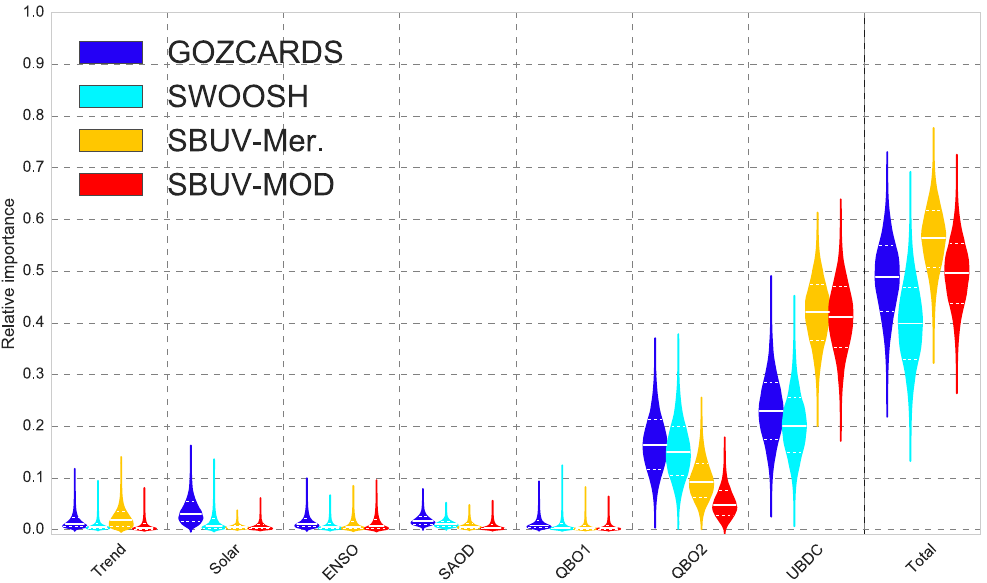
Figure 12. Similar in format and method to Fig. 11a, the relative importance of each regressor using the coefficient of determination ( R 2 ), as well as the combined total, is shown from multiple linear regression analysis of four ozone composite datasets at 1.6hPa for 20 ◦ S–20 ◦ N and 1998–2012. The most-likely value is given by the central, solid white line, and the dotted lines are the 68% confidence intervals. Distributions were calculated from 10000 bootstrapped samples of each of the possible 5040 regressor orderings.